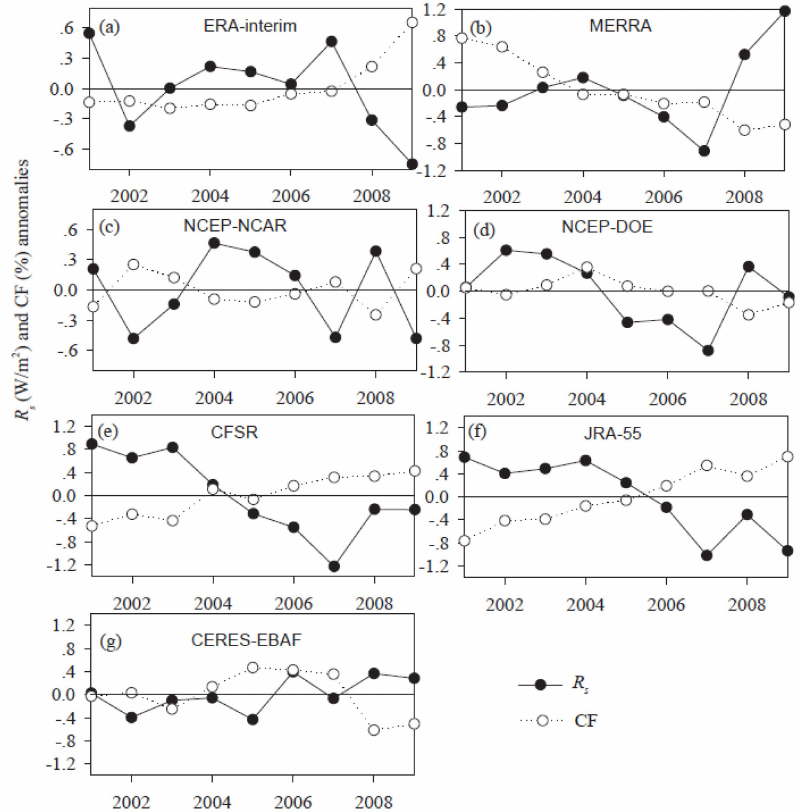
Figure 10. Global long-term variability of cloud fraction (CF) and R s obtained from the global reanalyses and CERES: ( a ) ERA-Interim; ( b ) MERRA; ( c ) NCEP-NCAR; ( d ) NCEP-DOE; ( e ) CFSR; ( f ) JRA-55; ( g ) CERES. 3.3. Global Annual